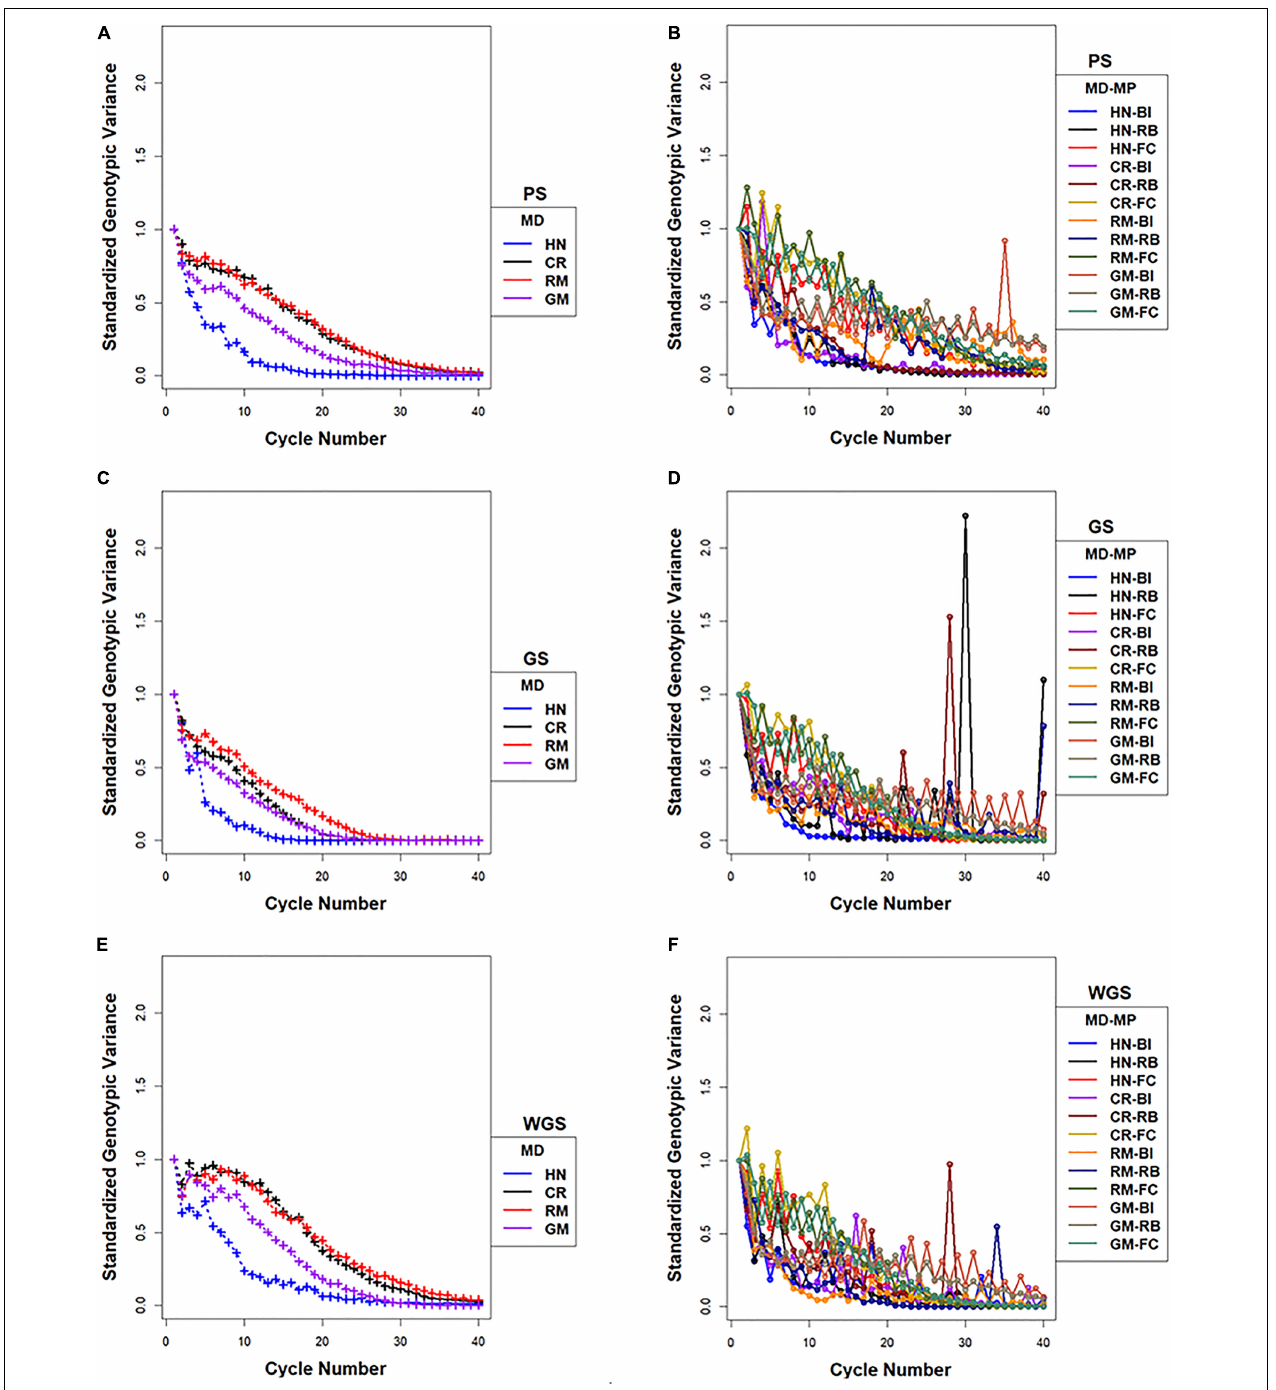
FIGURE 6 | Standardized genotypic variance across 40 cycles of recurrent selection on centralized (A,C,E) and family island (B,D,F) populations, using Phenotypic Selection (PS) (A,B) , Genomic Selection (GS) (C,D) , and Weighted Genomic Selection (WGS) (E,F) for the four mating designs (MD): Hub Network (HN), Chain Rule (CR), Random Mating (RM), and Genomic Mating (GM). Ten percent of lines are selected for crossing. The genetic architecture in the initial simulated founder lines consisted of 400 additive QTL uniformly distributed throughout the genome and expressed broad sense heritability on an entry mean basis of 0.7. Genetic variance is standardized to the average genotypic variance in founder populations in cycle “0.” Average island genetic variance refers to genetic variance within families averaged across 20 families. Migration policy in the island models included “Best Island” (BI), “Random Best” (RB), and “Fully Connected” (FC) with bidirectional exchange of two immigrants and emigrants every other cycle of selection. GP models are updated every cycle in GS and WGS using training sets with data from all prior cycles of selection.